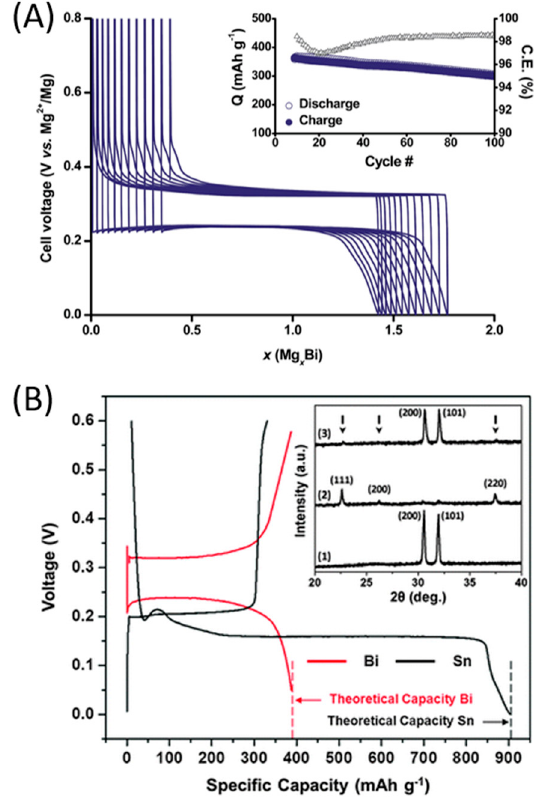
Figure 8. ( A ) Galvanostatic curve at 2C, after initial activation sweeps, obtained with copper foil supported electrode based on micrometric bismuth particles embedded by carbon additives. Inset: evolution of discharge and charge capacities and Coulombic efficiency. ( B ) First cycle galvanostatic magnesiation/de-magnesiation curves for Sn/Mg and Bi/Mg half cells (with organohaloaluminate electrolyte); inset: XRD spectra for (1) as-fabricated tin, (2) magnesiated tin (or Mg 2 Sn—peak positions marked with arrows) and (3) de-magnesiated Mg 2 Sn. Adapted with permission from [162]. Copyright Royal Society of Chemistry, 2015. Adapted with permission from [26]. Copyright Informa UK Limited, 2017.